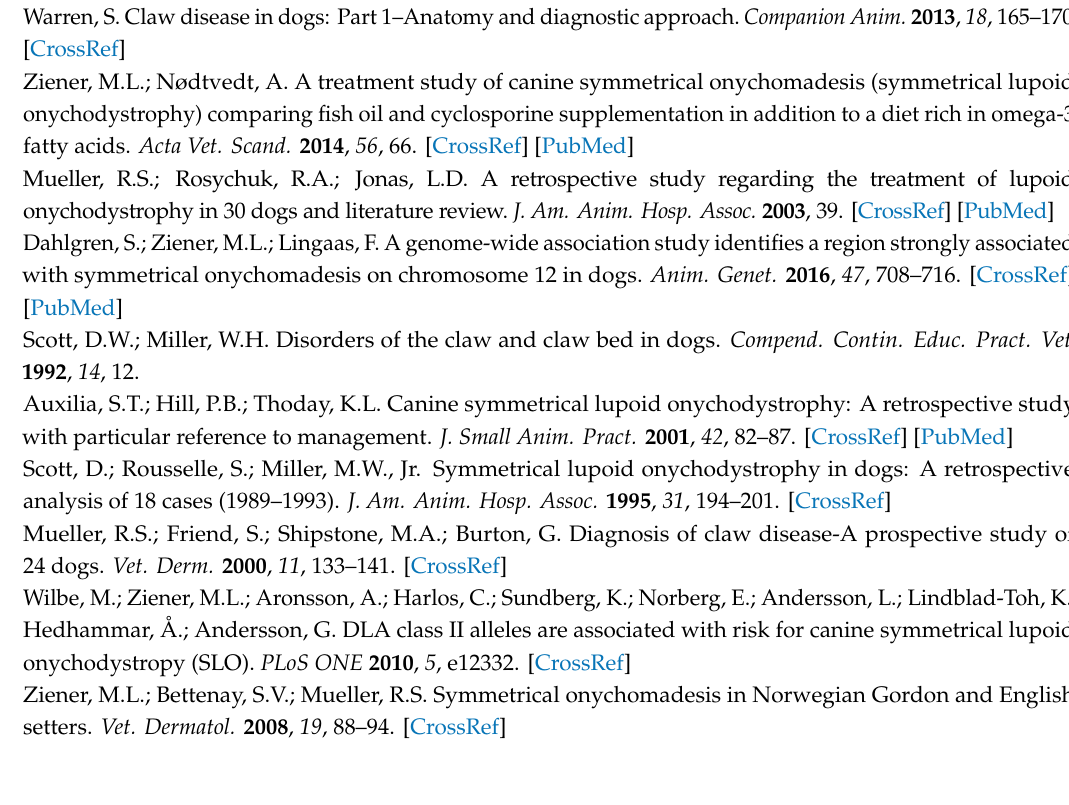
Figure S1: Chi-square based allelic association (a) and association test after 100,000 permutations (b) for the follow-up GWA analysis including SLO dogs homozygous for DLA risk haplotypes and controls that were not homozygous for DLA risk haplotypes. The blue and red lines indicate suggestive ( − log10[ p -value] ≥ 5) and Bonferroni-adjusted genome-wide significance threshold ( − log10[ p -value] ≥ 6.3), respectively; Figure S2: Manhattan plot resulting from the implementation of the genome-wide e ffi cient mixed model association algorithm (GEMMA) for the entire dataset (a) and subset of dogs carrying DLA class II risk haplotypes for SLO (b). The blue and red lines indicate suggestive ( − log10[ p -value] ≥ 5) and Bonferroni-adjusted genome-wide significance threshold ( − log10[ p -value] ≥ 6.3), respectively; Table S1. Allele and genotype frequency for the genome-wide significant SNPs in 82 unrelated Bearded Collies (30 SLO, 52 controls); Table S2: List of SNPs in each CFA12 haplotype block associated with SLO (permutated p -value < 0.01) as determined by Haploview in 101 Bearded Collies (65 controls, 36 SLO) and their location based on CanFam3.1; Table S3: Frequency and odds ratio (OR) of the genotypes observed in the 12 haplotype blocks on CFA12. Locations are based on the CanFam3.1 reference genome. Nucleotides that di ff er from the major allele are underlined in each alternate allele within a block. The bolded values were statistically significant at p < 0.05; Table S4: List of SNPs in each CFA17 haplotype block associated with SLO (permutated p -value < 0.01) as determined by Haploview in 101 Bearded Collies (65 controls, 36 SLO) and their location based on CanFam3.1; Table S5: Frequency and odds ratio of the genotypes observed in the three haplotype blocks on CFA17. Locations are based on the CanFam3.1 reference genome. Nucleotides in each alternate allele that di ff er from the most common allele in each block are underlined. The bolded values were statistically significant at p <